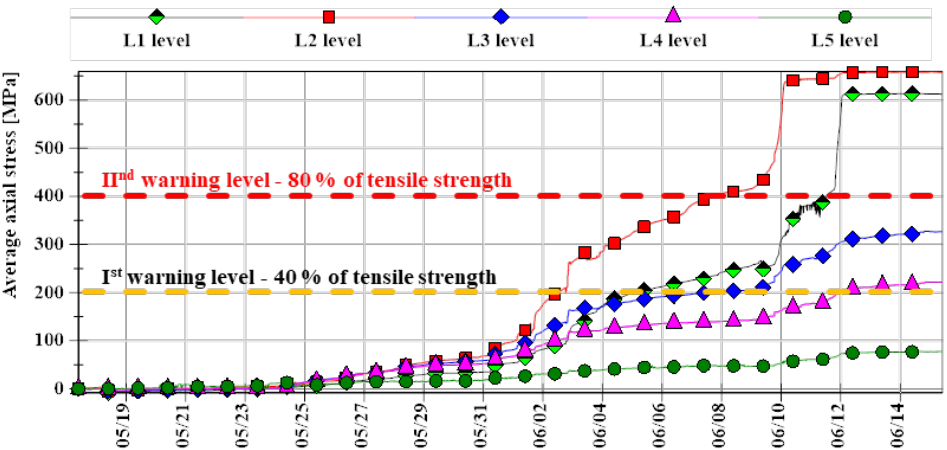
Figure 6. Example of the axial stress measurement performed with the 5-level instrumented rock